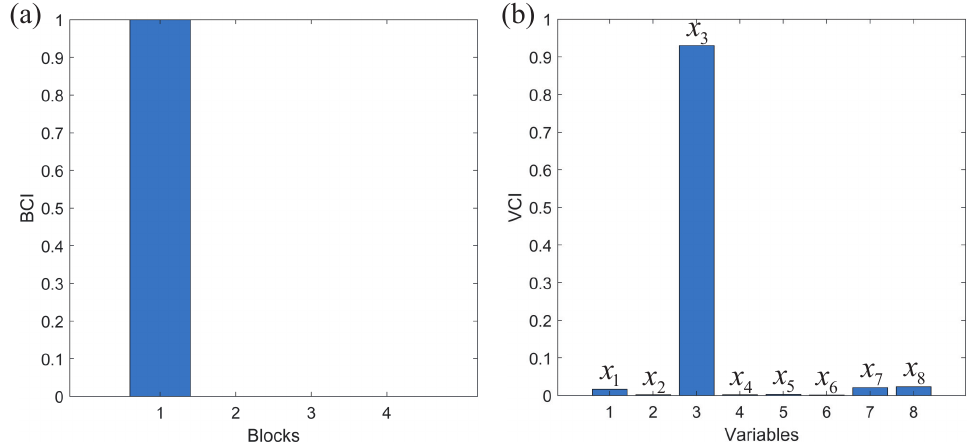
Figure 6. The anomaly isolation results in numerical simulation experiment. ( a ) BCI; ( b ) VCI.